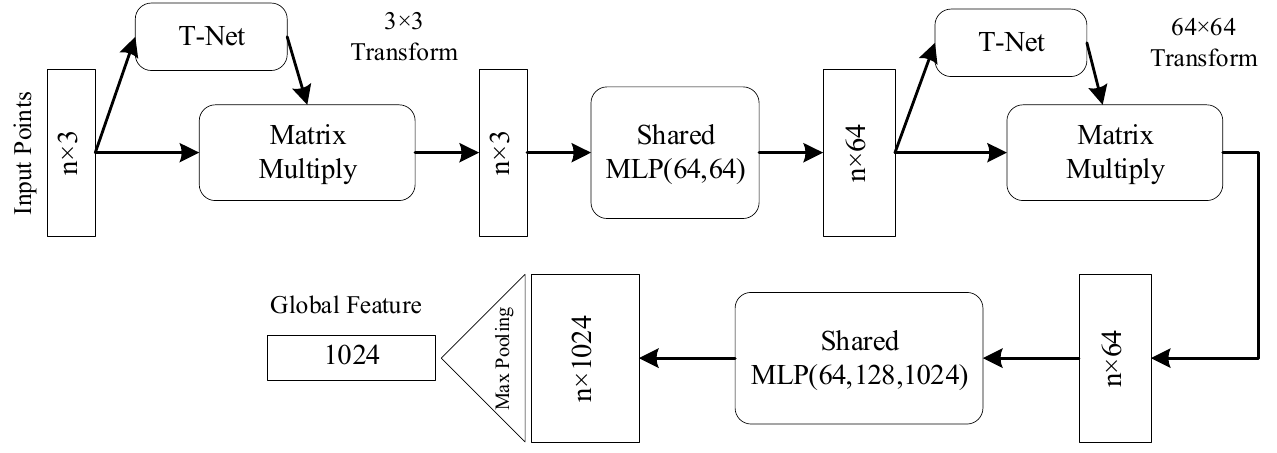
Figure 2. The network can directly use the 3D coordinates of the point cloud as input.